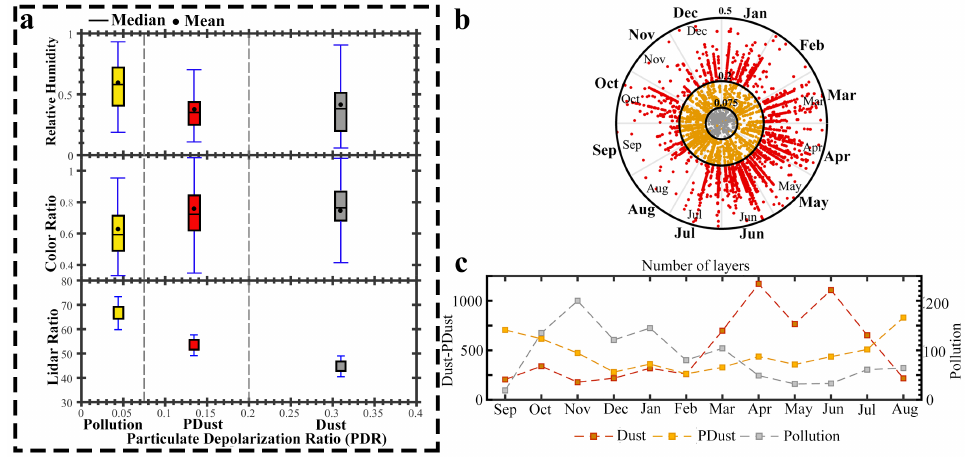
Figure 9. ( a ) Bar plots show the median (horizontal line), 25–75 percentile (box), and 5–95 percentile (whisker) of layer-mean particlulate linear depolarization ratio and lidar ratio at 532 nm wavelength, the same for color ratio and relative humidity. ( b ) Polar scatter plots of daily IPDR values along the period of study. ( c ) Monthly distribution of the observed layer containing different aerosol types (Dust, Polluted dust,